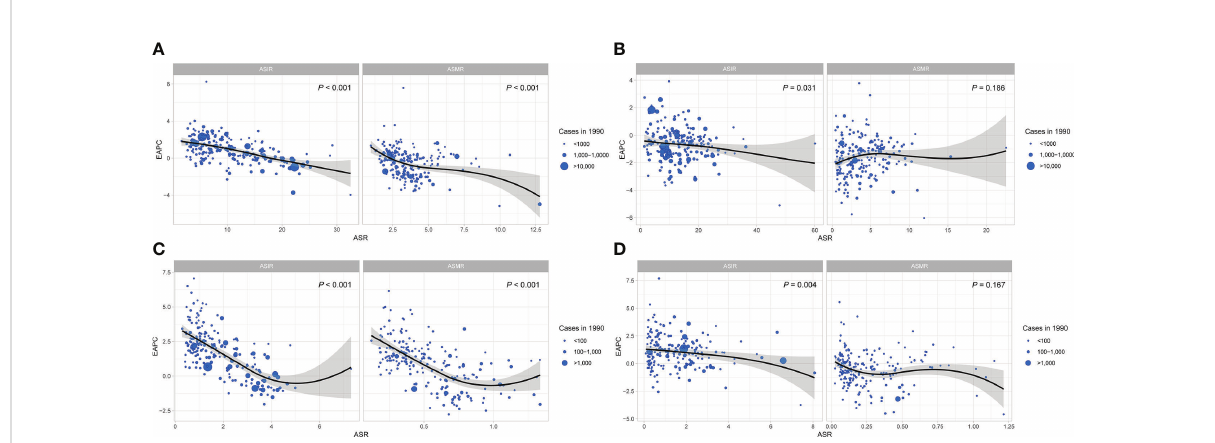
FIGURE 5 The correlation of EAPC and ASR of FeBGCs among AYAs in 1990. The correlation of EAPC and ASR of female breast cancer (A) , cervical cancer (B) , ovarian cancer (C) , and uterine cancer (D) among AYAs in 1990. The size of the blue circle is increased with cancer cases, and one circle represents a speci fi c country or region. The P values were derived from Pearson correlation analysis. The black line represents the average expected relationship between SDIs and ASIRs for female breast and gynecologic cancers based on values from all countries and regions from 1990 to 2019. ASR, age-standardized rate; ASIR, age-standardized incidence rate; ASMR, age-standardized mortality rate; EAPC, estimated annual percentage change; FeBGCs, female breast and gynecologic cancers; SDI, social-demographic